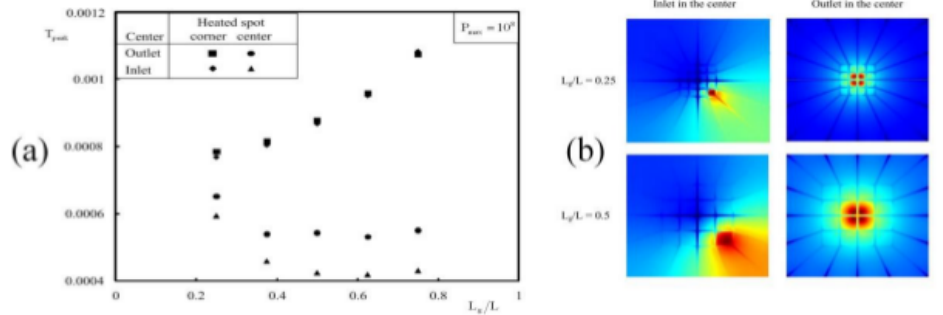
Figure 7: (a) Peak temperature relative to L g / L when the flow direction and the concentrated heat generation location change. (b) The tem- perature distribution in the mid-plane of the